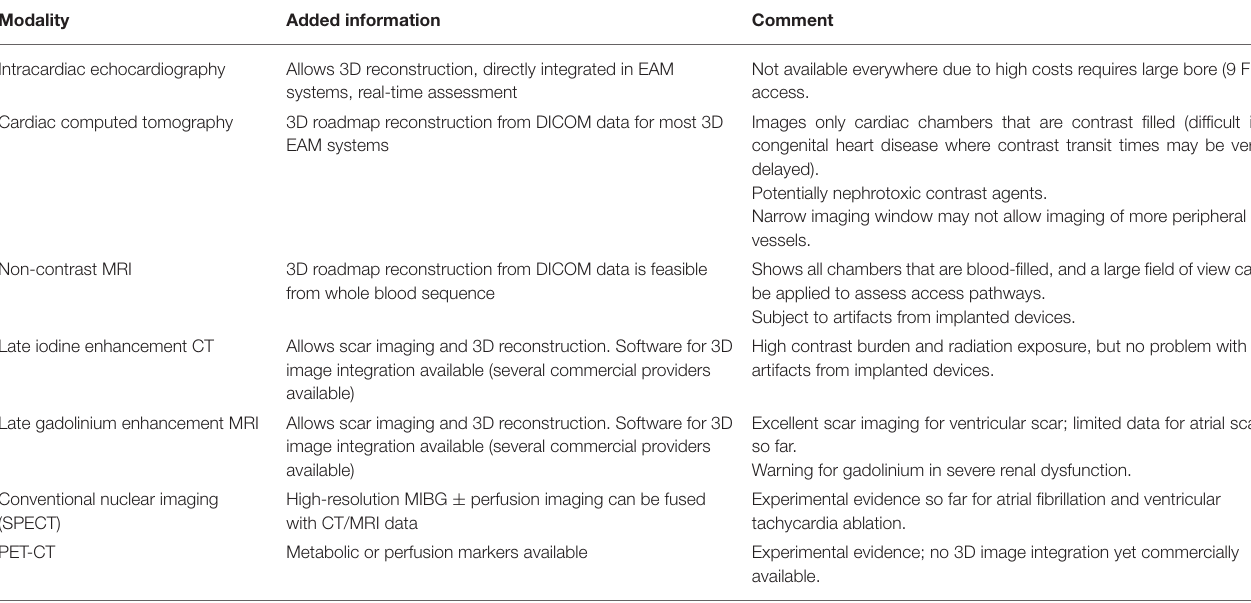
TABLE 1 | 3D image integration options for